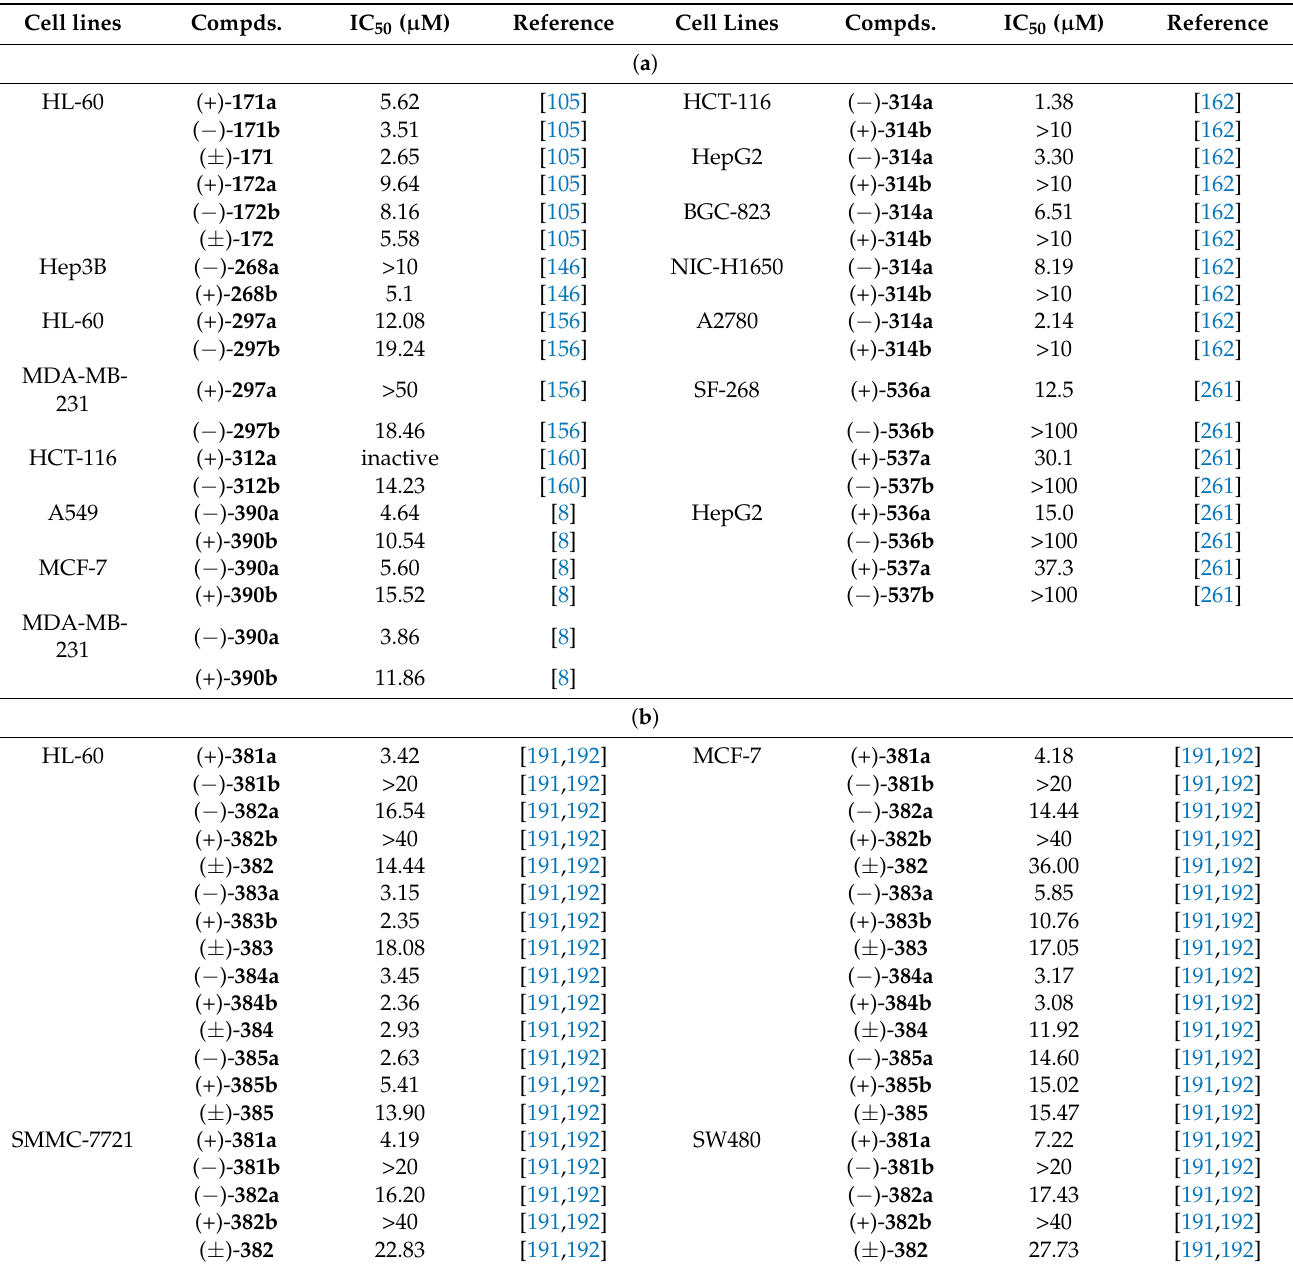
Table 2. Cytotoxic activities of enantiomers. ( a ) part 1; ( b ) part